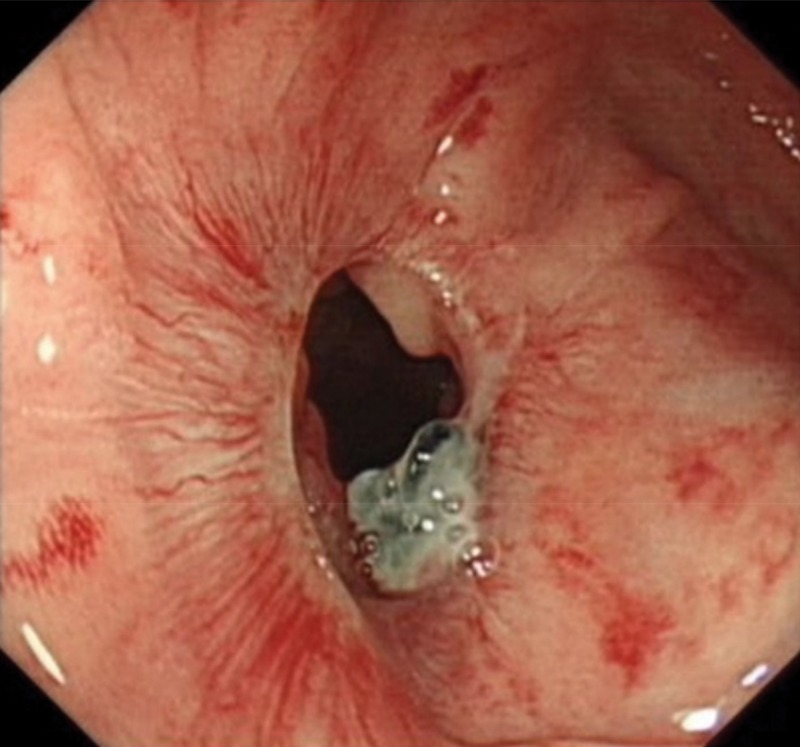
One patient experienced anastomosis stricture after 3 months post-operation as determined by an electronic colonoscopy.